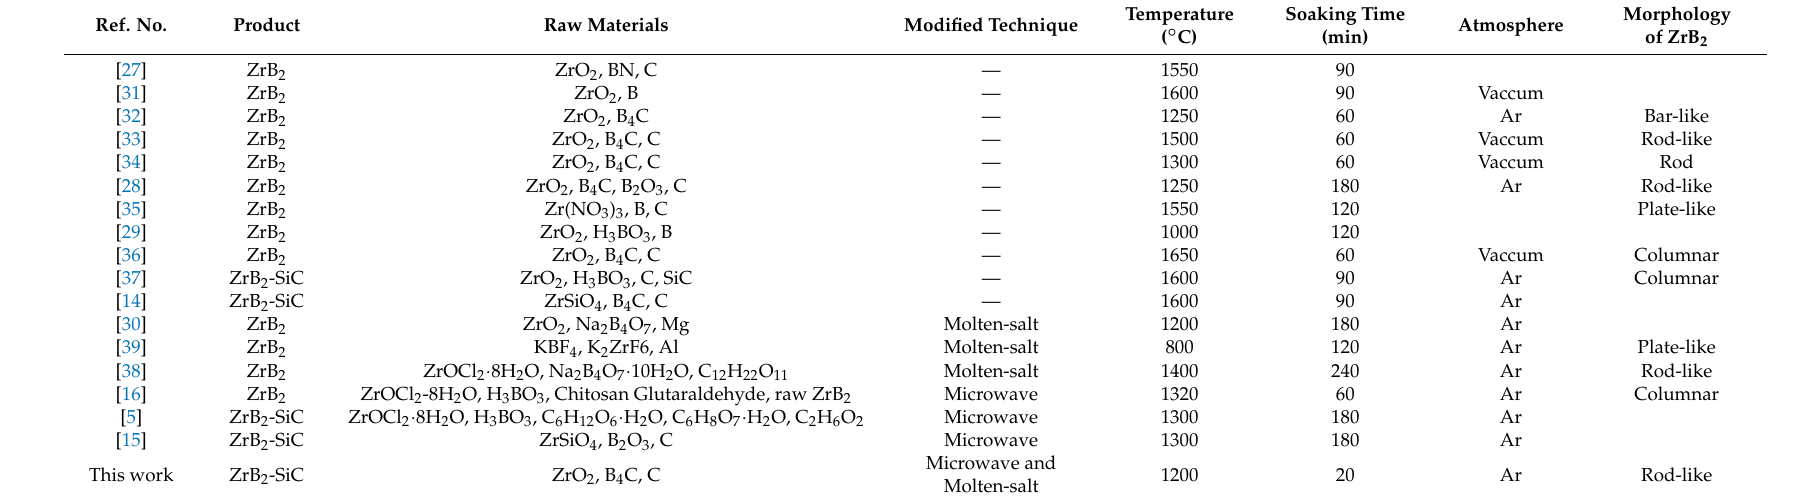
Table 2. Ingredients, modified techniques, processing conditions, and product morphology of previous literatures on the preparation of ZrB 2 or ZrB 2 -SiC powders by thermal-reduction-based